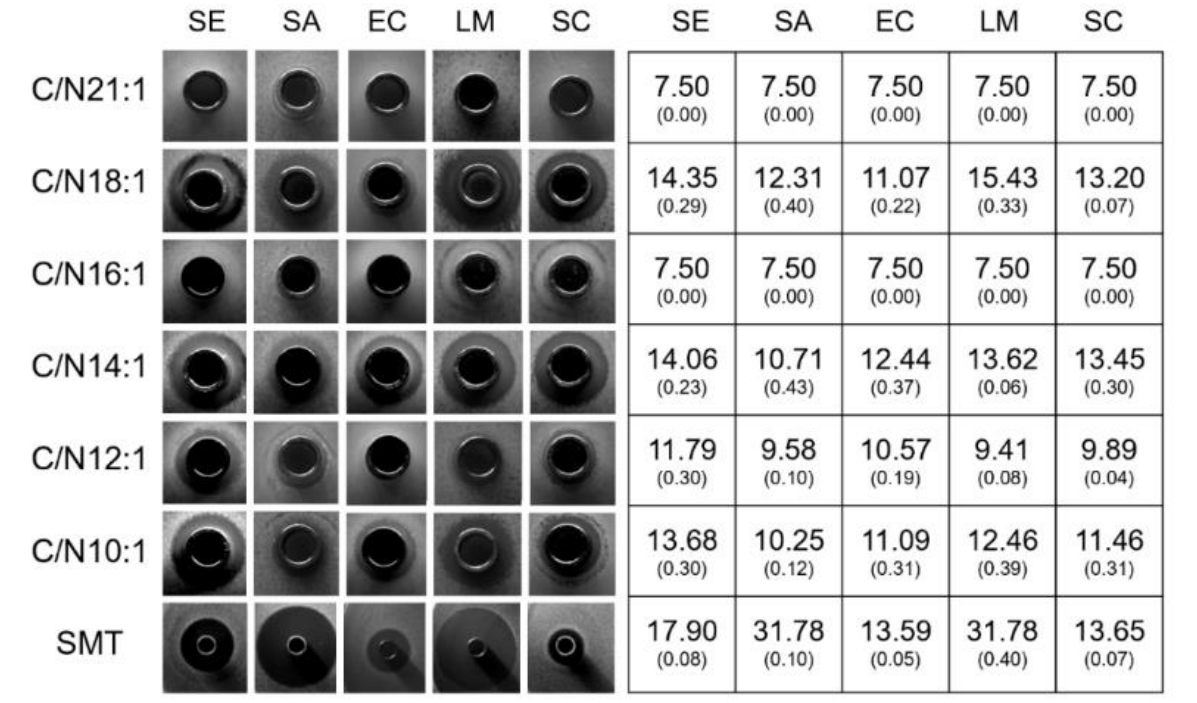
Figure 4. The inhibition zone assay of the crude AMP extracts and the antibiotic control sulfa- monomethoxine. Diameters of inhibition zone (DIZ) were illustrated in the table with large numbers representing the mean value and small numbers representing the standard deviation (n = 3). SE, Salmonella enterica serovar typhimurium; SA, Staphylococcus aureus ; EC, Escherichia coli O157:H7 ; LM,